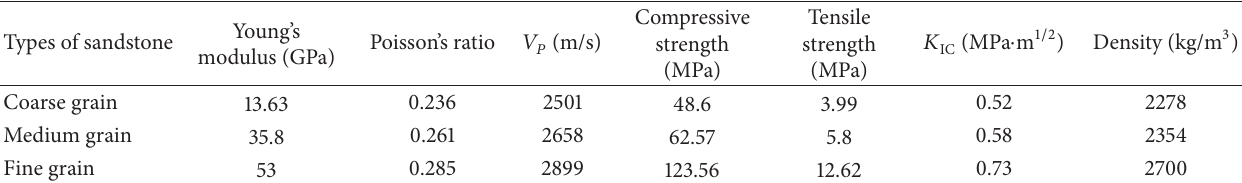
Table 1: Basic parameters of the sandstones with different sizes.